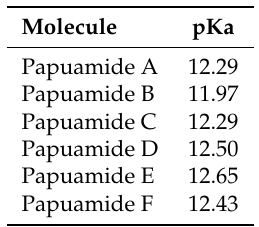
Table 3. pKas of Papuamides